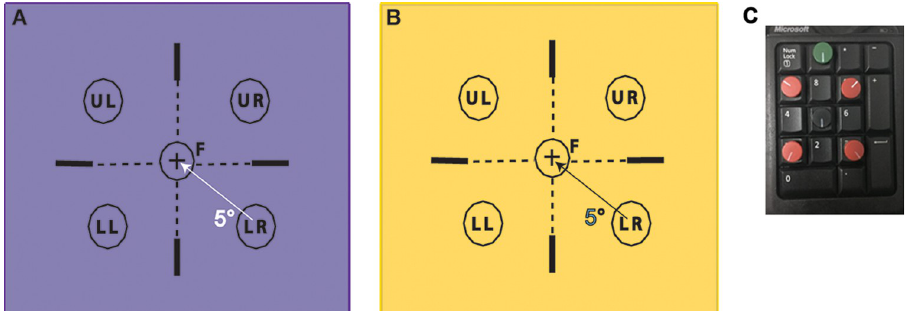
Fig 1. Schematic representation of the stimulus display for mesopic (panel A) and photopic (panel B) conditions used in this study.